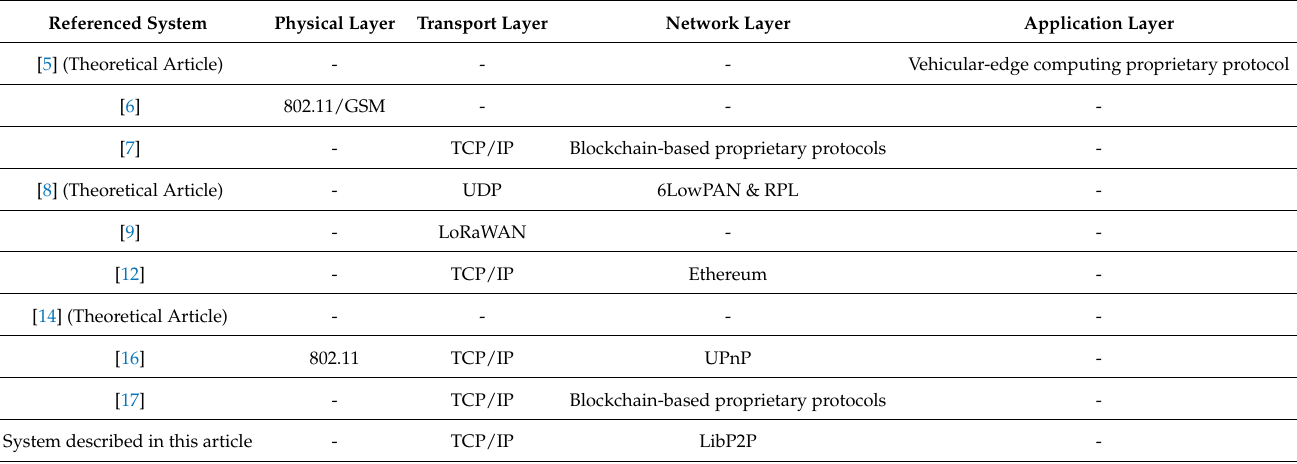
Table 2. Protocols used in theoretical and practical OEC solutions of the state of the